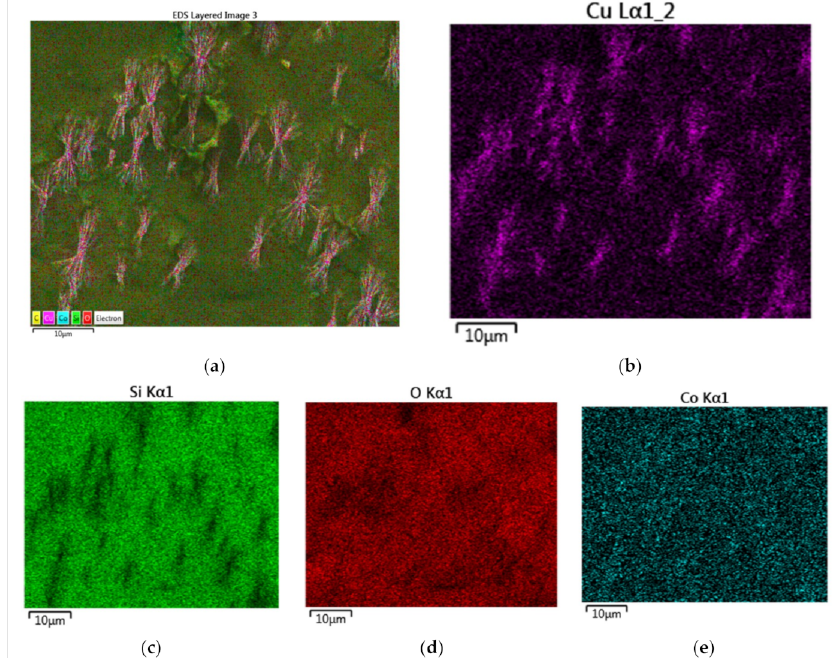
Figure 32. EDS image and the elemental mapping of Co / Cu / Si = 1 / 1 / 8 catalyst showing the copper rich regions on a Co / Si rich surface. ( a ) EDS image; ( b ) Cu mapping; ( c ) Si mapping; ( d ) O mapping; ( e ) Co mapping. Scale bar = 10 µ m. See Table 12 for elemental composition in various regions.